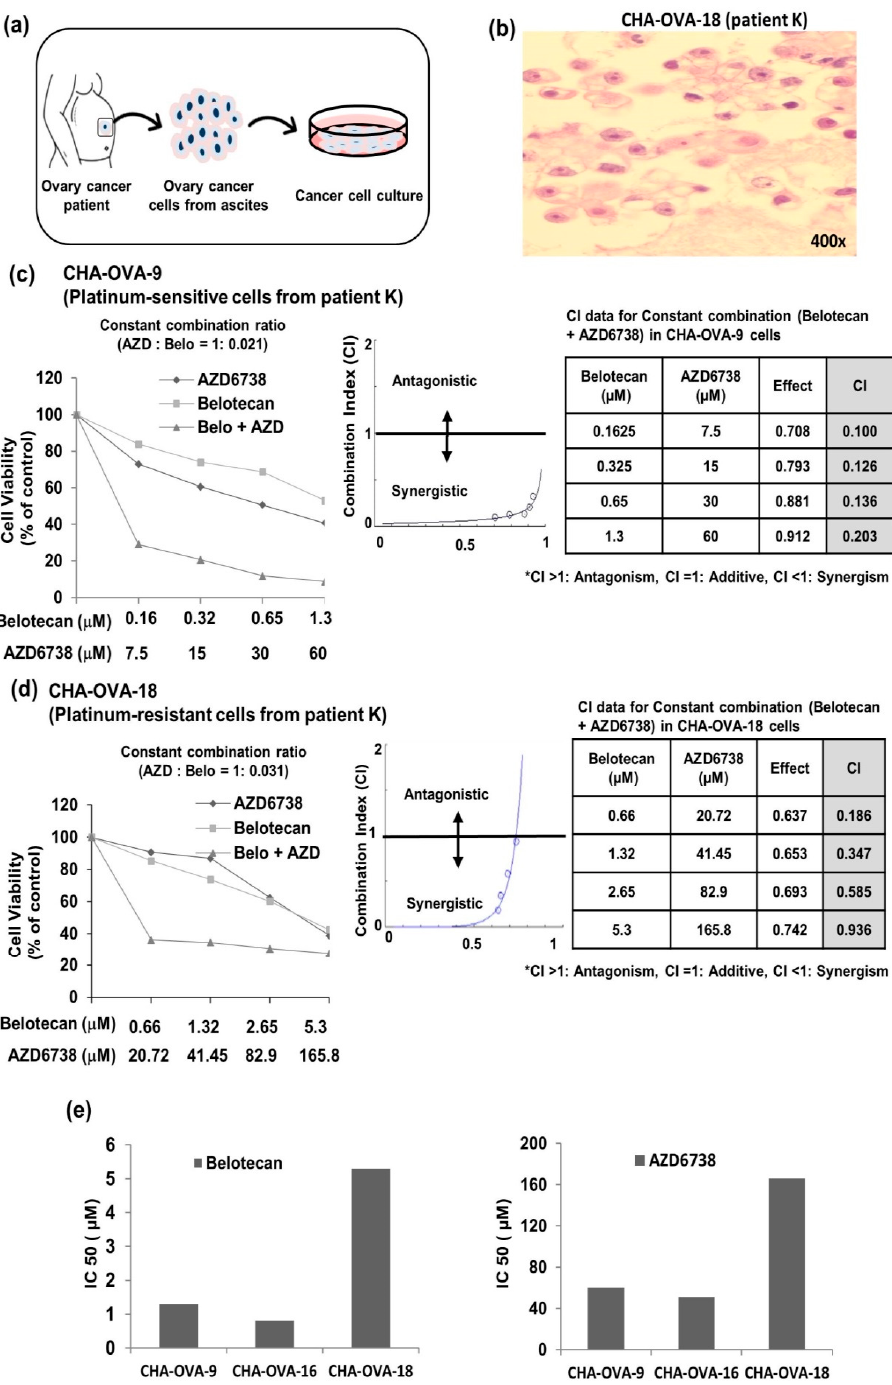
Figure 6. AZD6738, an ATR inhibitor, in combination with belotecan demonstrates synergism in vitro primary ovarian cancer cells: ( a ) schematic diagram for the collection of ascitic fluid from ovarian cancer patients and the culture of primary cancer cells. ( b ) Representative image of H&E staining, which confirmed that the CHA-OVA-18 cells were ovarian cancer cells. ( c , d ) Combination of belotecan and AZD6738—in a constant combination ratio of both drugs—demonstrated synergistic cytotoxicity in both CHA-OVA-9 (platinum-sensitive) ( c ) and CHA-OVA-18 (platinum-resistant) primary ovarian cancer cells ( d ). ( e ) Bar graph representing the comparison of IC 50 among the three primary ovarian cancer cells—namely CHA-OVA-9, CHA-OVA-16, and